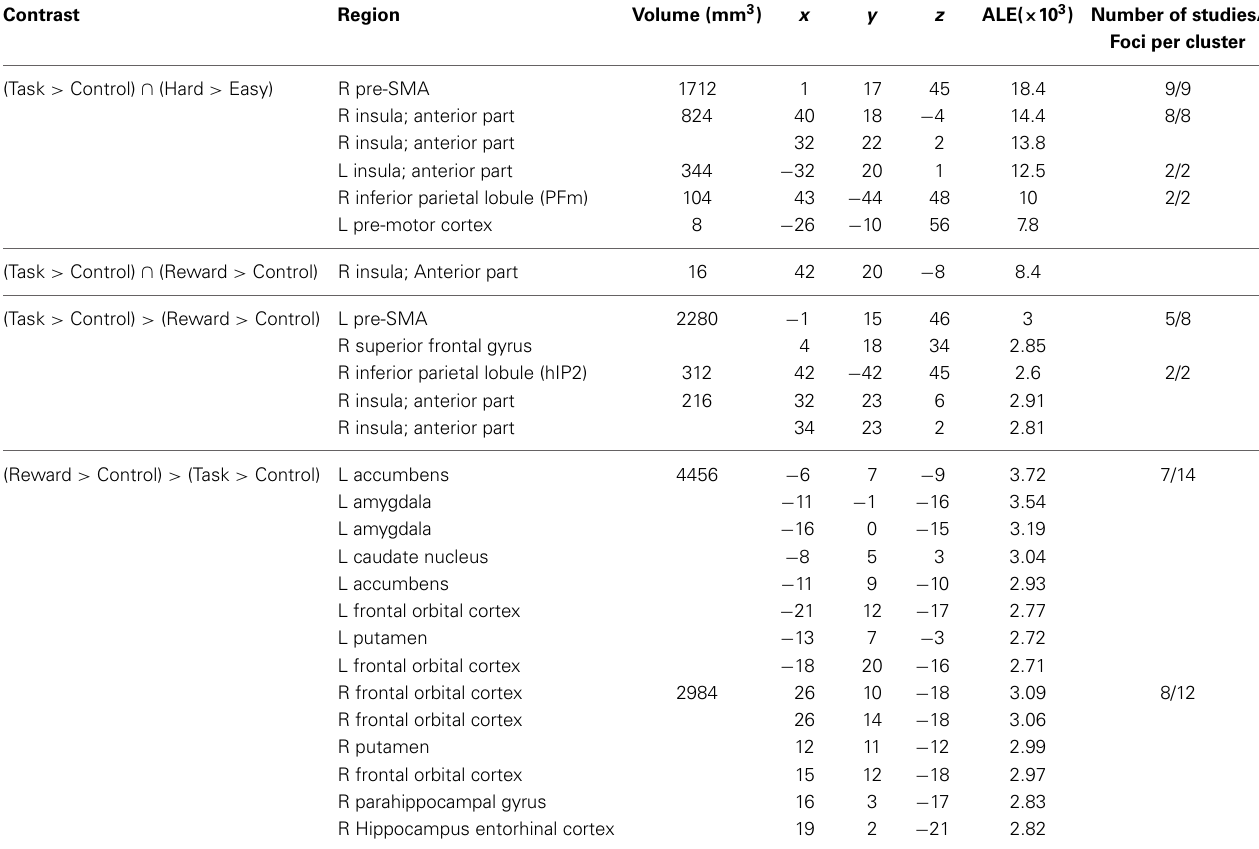
Table 5 | Significant activation clusters of the conjunction and subtraction analyses.